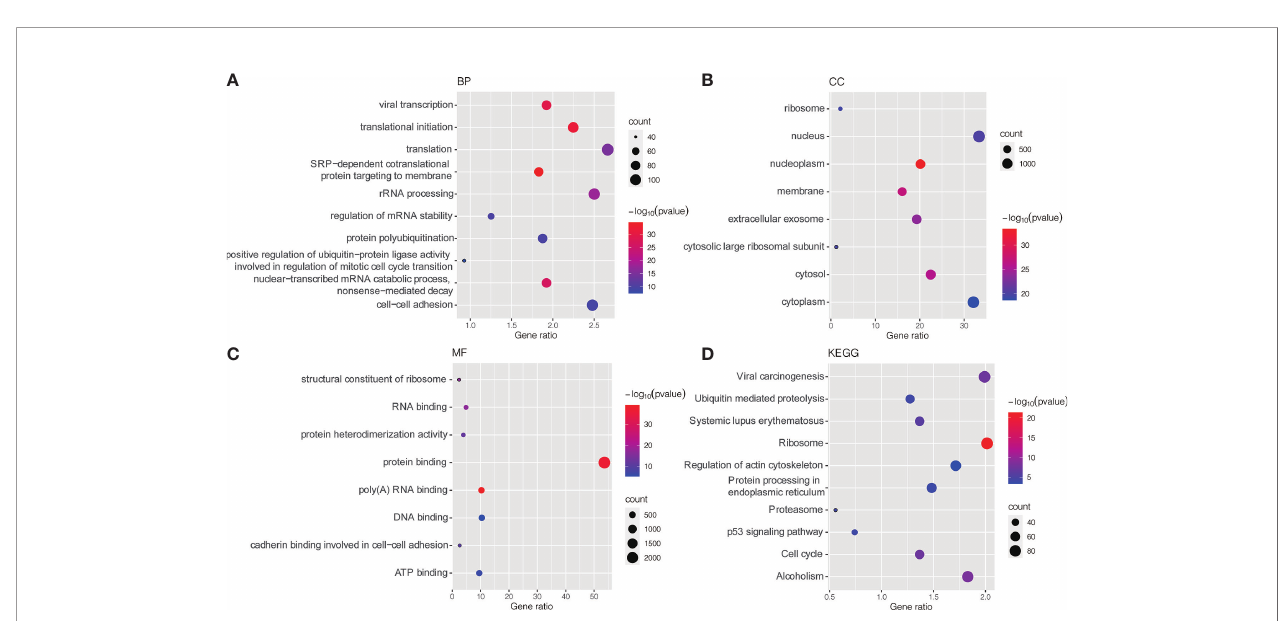
FIGURE 3 | GO and KEGG pathway enrichment analysis of DEMs. (A) Bubble plot of BP; (B) Bubble plot of CC; (C) Bubble plot of MF; (D) Bubble plot of KEGG. GO, Gene Ontology; KEGG, Kyoto Encyclopedia of Genes and Genomes; BP, biological process; CC, cellular component; MF, molecular